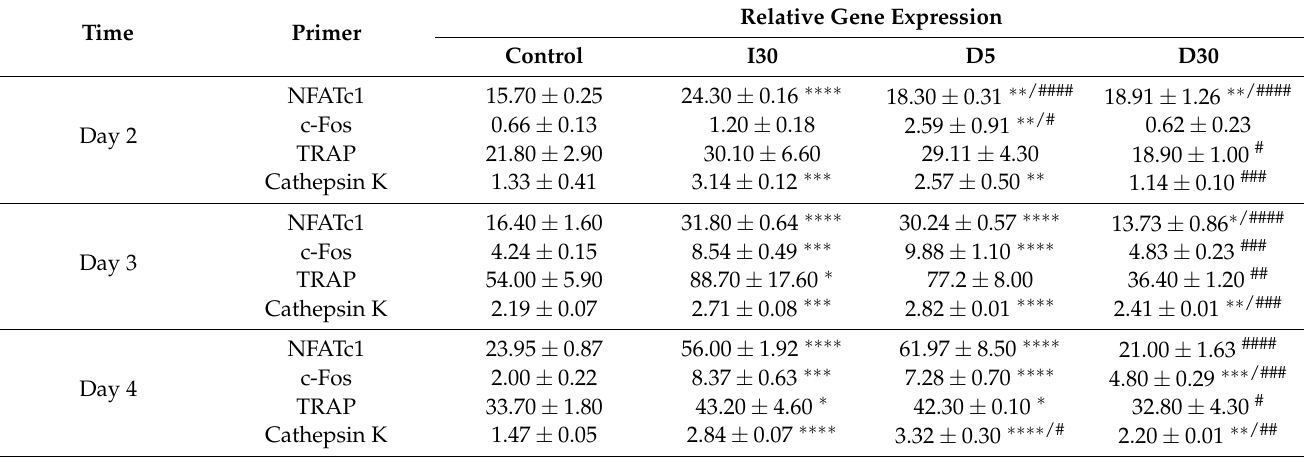
Table 6. Relative gene expression of osteoclast differentiation by q-PCR (mean ± SD). Relative Gene Time Primer